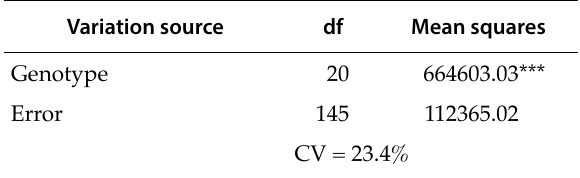
Table 5. Analysis of variance of ascochyta blight severity (measured as Area Under the Disease Progress Curve) of 21 chickpea genotypes growing under controlled condi-